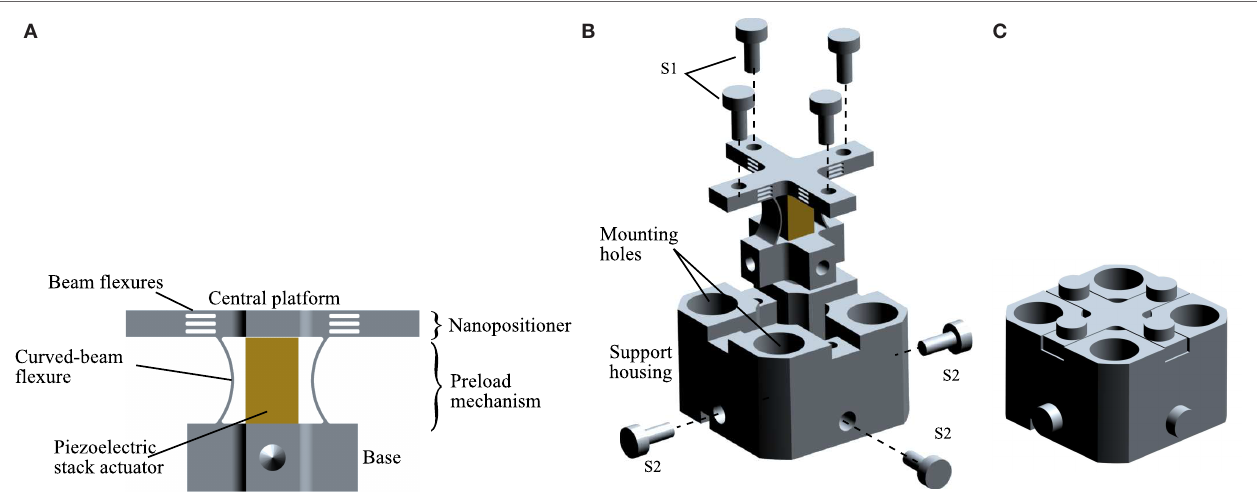
FIGURE 8 | (A) A high-speed nanopositioning device with a novel preload mechanism design (Yong, 2016). (B,C) Exploded and assembled views of the device.